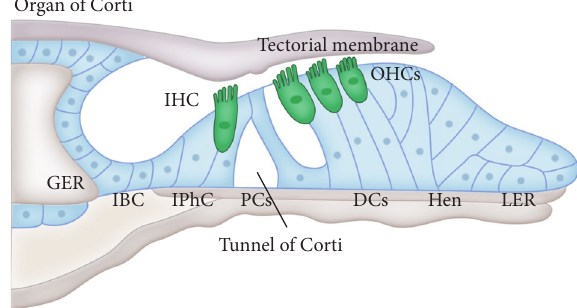
Figure 1: Schematic model of the organ of Corti. IHC: inner hair cell; OHCs: outer hair cells; PCs: inner and outer pillar cells; IPhC: inner phalangeal cell; DCs: Deiters’ cells; IBC: inner border cell; Hen: Hensen’s cell; GER: greater epithelial ridge; LER: lesser epithelial